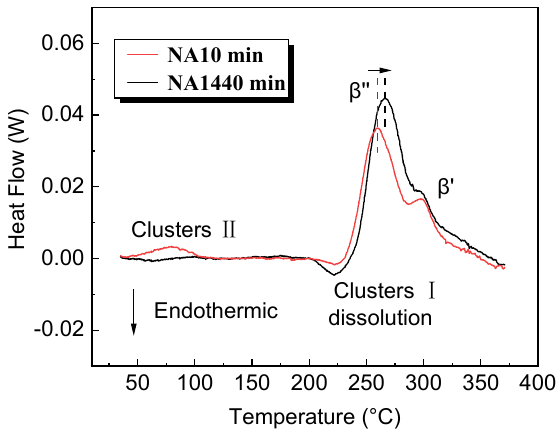
Figure 3. DSC flow curves of the Al-Mg-Si alloy at NA10 min and NA1440 min.